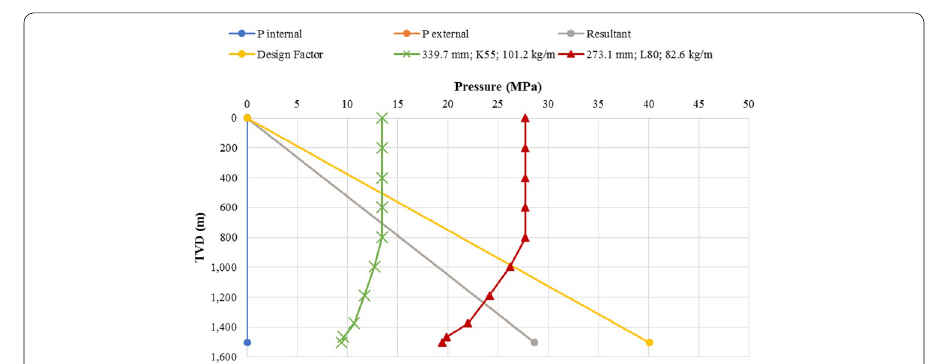
Fig. 9 Collapse load for production casing and tieback casing of well